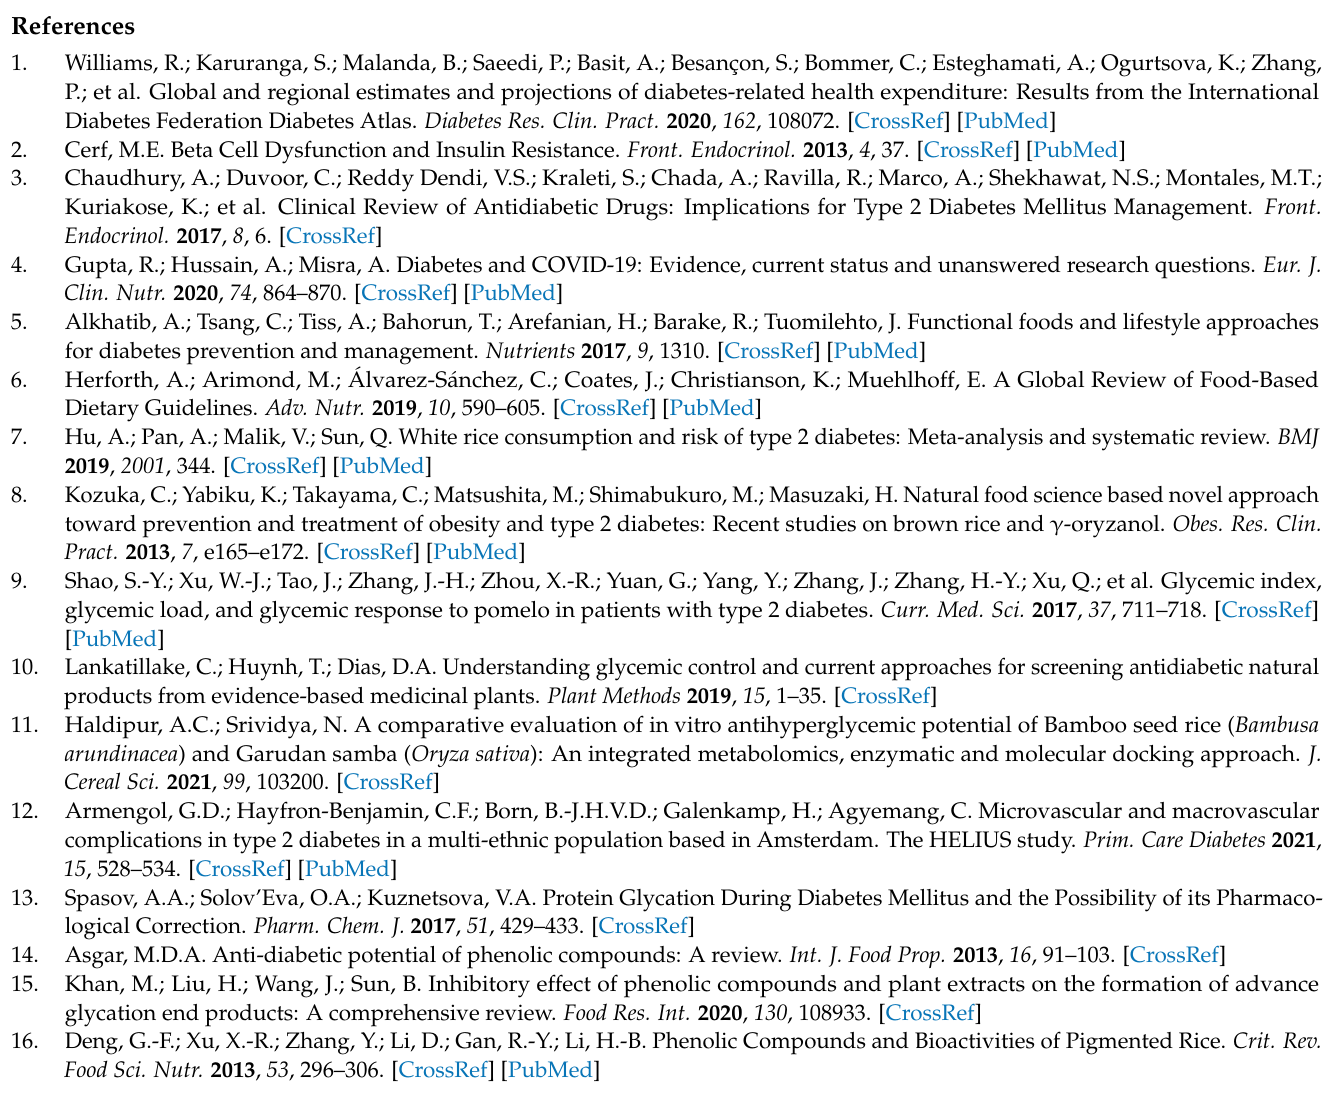
Karungkuruvai, Table S1: Morphological details of traditional experimental red rice varieties, Table S2: Retention time, m/z ratio, formula, diff, MS fragments and scores of the phenolic compounds identified in the experimental samples, Table S3: ADME properties of the abundant red rice phenolic